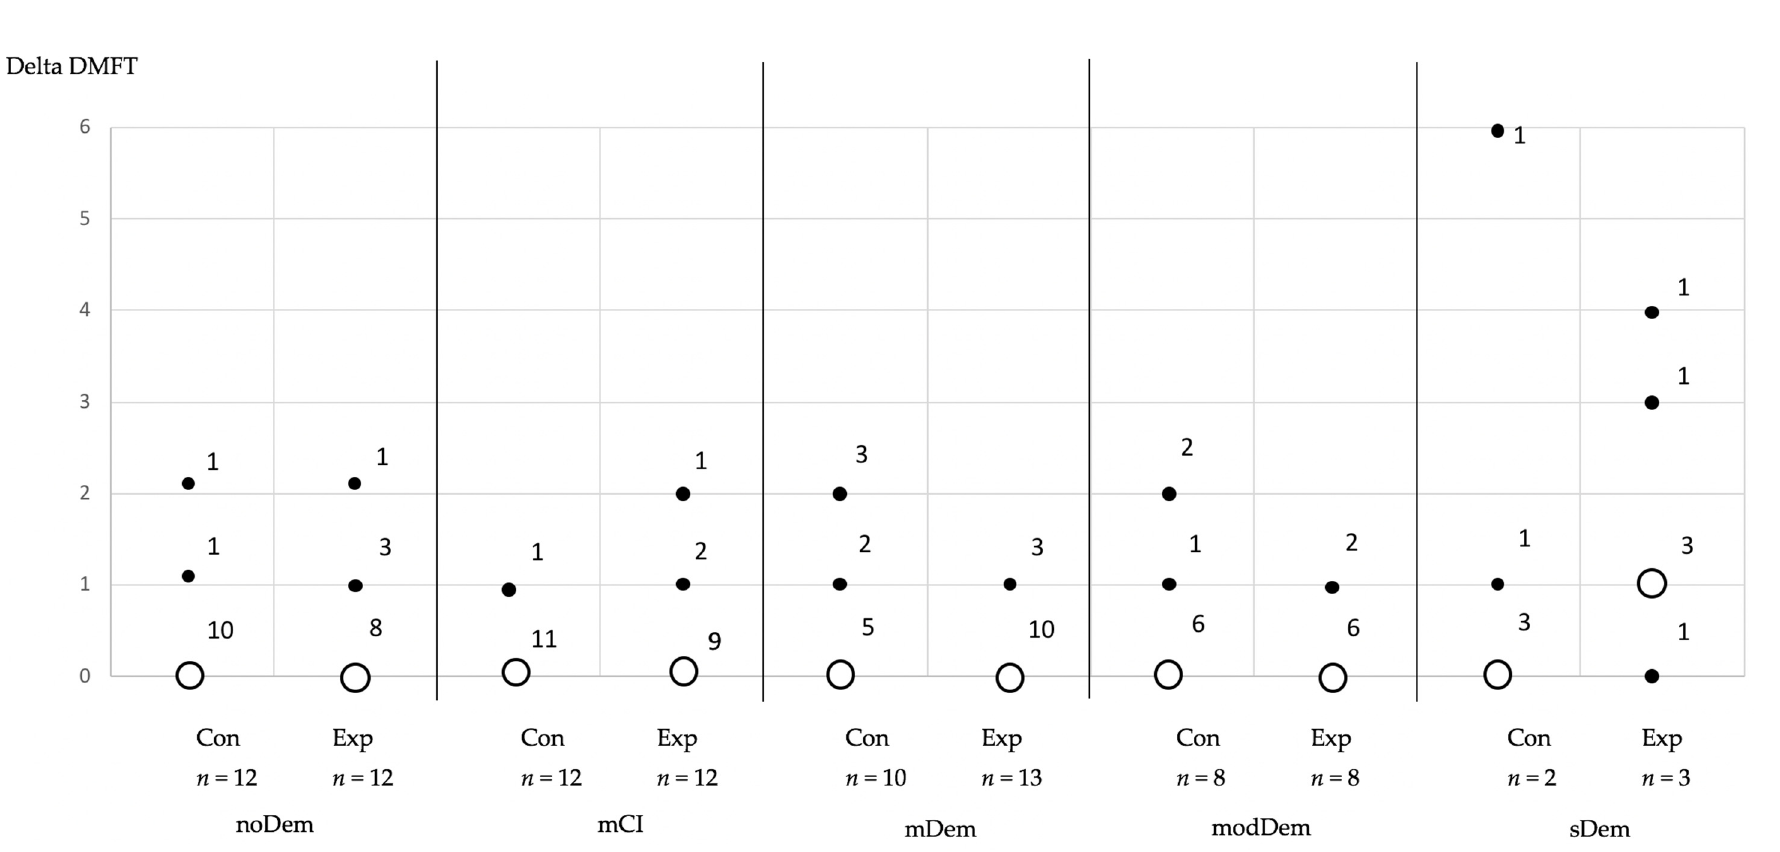
Figure 1. Changes in the DMFT index over time (final minus baseline), shown as ∆ DMFT, separated by the mini mental state examination (MMSE) group and subgroup (control and experimental group). The legends at the points indicate the number of subjects with the corresponding ∆ DMFT value. (Con: control group; Exp: experimental group) (MMSE groups—noDem: no dementia; mCI: mild cognitive impairment; mDem: mild dementia; modDem: moderate dementia; sDem: severe dementia) (hollow circles correspond to the majority of counts of changes in each evaluation group, filled circles demonstrate minor amount of counts of changes in each evaluation group, numbers at hollow and filled circle correspond to number of changes).